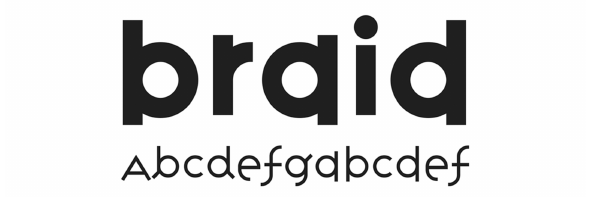
Figure 8. The typeface ‘Variex’ by Zuzana Licko and Rudy Vanderlans